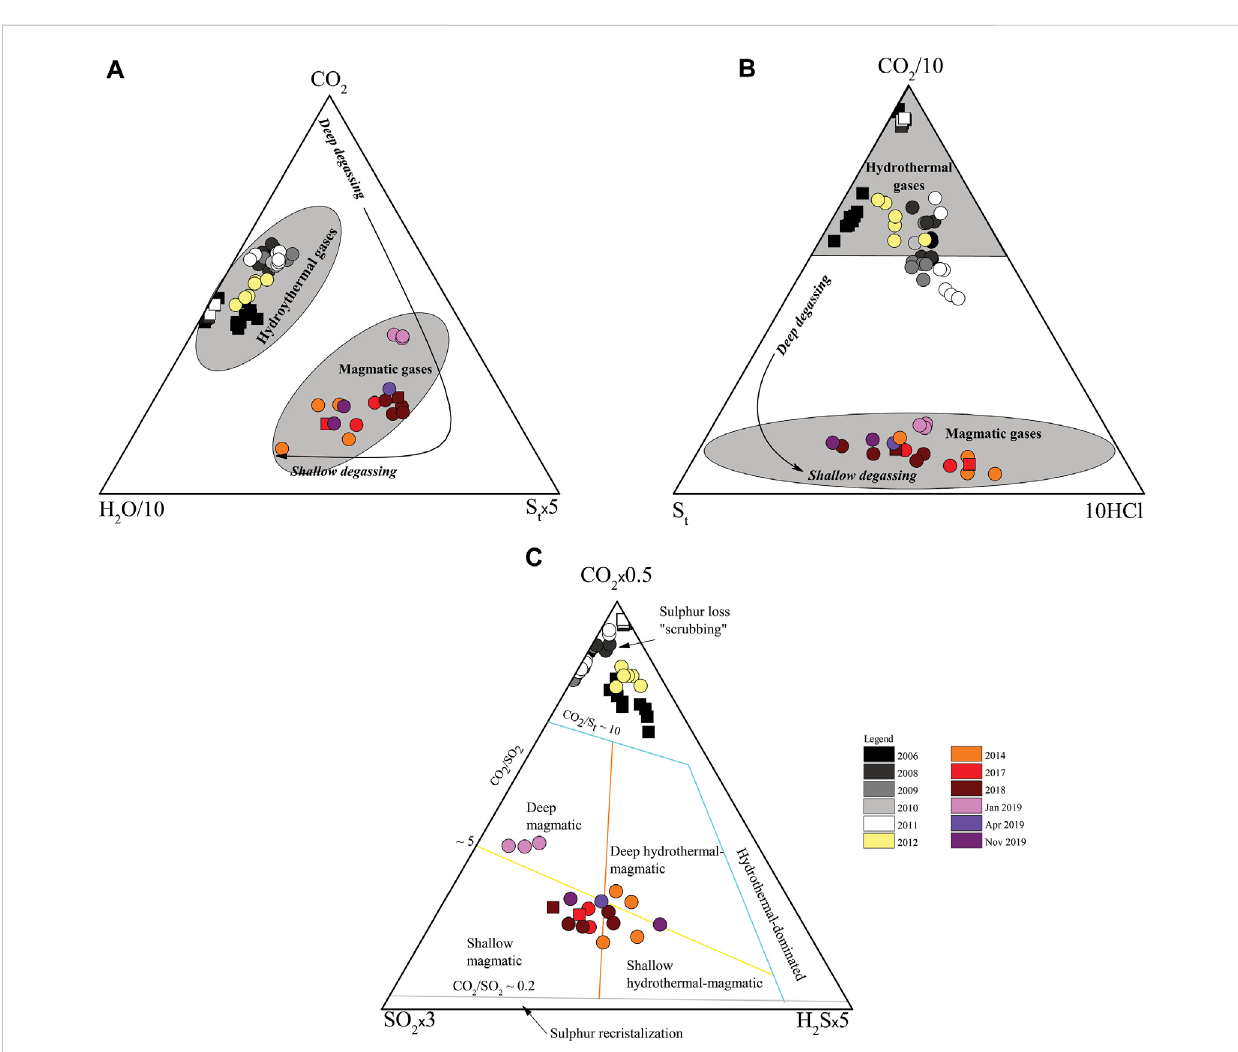
FIGURE 3 Ternary diagrams for Lastarria volcano gas compositions. (A) H 2 O/10-CO 2 -S t x5; (B) S t -CO 2 /10-HClx10; (C) SO 2 x3-CO 2 x0.5-H 2 Sx5. < 96 ° C fumaroles are shown as fi lled squares; > 120 ° C fumaroles are shown as fi lled circles. Hydrothermal and magmatic gases fi elds are highlighted in grey. Transition of deep-to-shallow degassing is shown as long black arrows. Classi fi cation of gases and limits of compositional fi elds for (C) diagram were adopted from Lages et al. (2019). S t correspond to to SO 2 +H 2